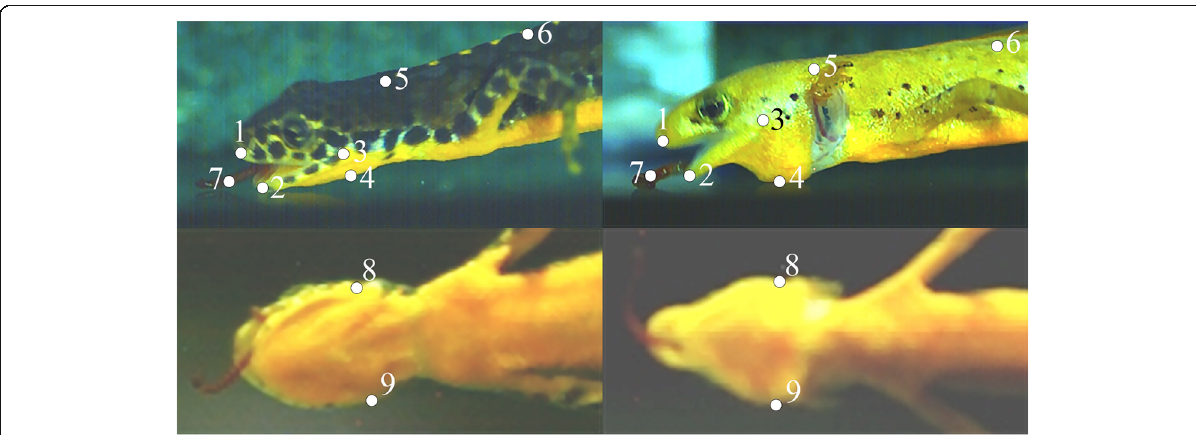
Fig. 1 Frame-shots showing the landmarks used to calculate movements and kinematic variables in metamorphs (left) and paedomorphs (right) in lateral (top) and ventral (bottom) views: 1, upper jaw tip; 2, lower jaw tip; 3, jaw joint; 4, hyobranchium; 5, nape; 6, trunk reference; 7, estimated center of mass of prey; 8, left jaw joint; 9, right jaw